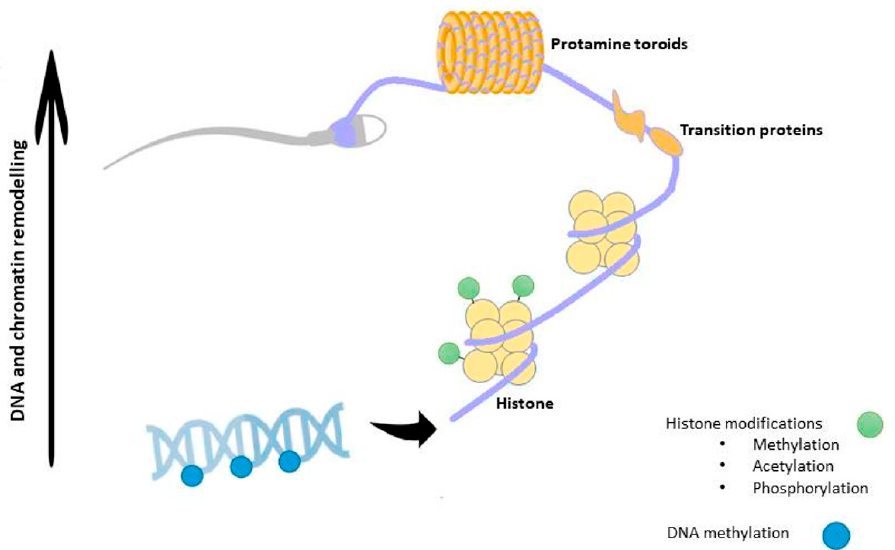
Figure 2. A schematic view of chromatin remodeling in SPZ. During spermiogenesis, cells suffer chromatin conformational changes regulated by epigenetic marks, ultimately resulting in an extremely condensed chromatin that protects SPZ from external assault. In this last step of spermatogenesis DNA is methylated, histones suffer posttranslational modifications and are replaced by transition proteins (TPs), an intermediary state of packaging that soon disappears. TPs are then exchanged with more basic proteins, the protamines. DNA strands are tightly wrapped to protamines, forming supercoiled doughnut-like structures named toroids, the basic packaging units of sperm chromatin. Of note, a small subset of histones escapes this fate and is not replaced.